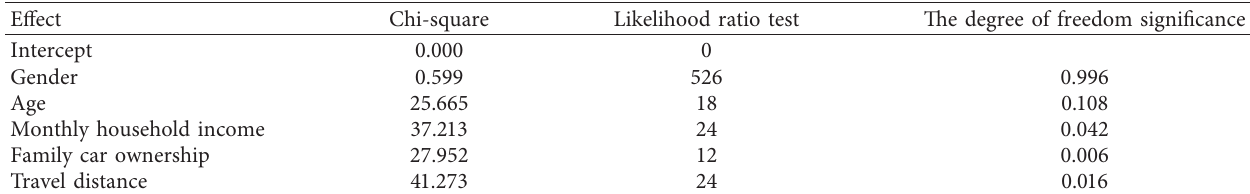
Table 5: Likelihood ratio test.